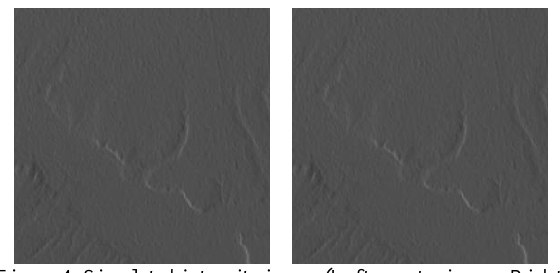
Figure 4. Simulated intensity image (Left: master image, Right: slave image)